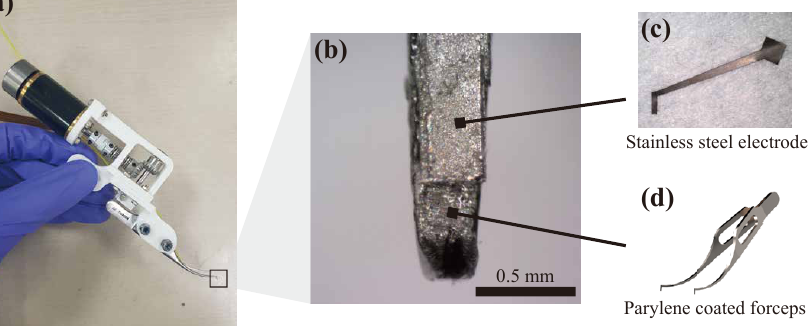
Figure 2. ( a ) Automatic grasping forceps consist of the sensor part and the actuation motor. ( b ) Fab- ricated sensor part. The first electrode is a metal forceps body itself. The surface of the forceps is coated with Parylene for insulation. The coating around the forceps tip is intentionally removed. The second electrode is made by cutting thin stainless steel sheet. The second electrode is attached to the surface of the forceps. ( c ) Second electrode made of stainless steel sheet. The large space in the upper right corner is for attaching electrodes. ( d ) CAD image of the forceps used in the